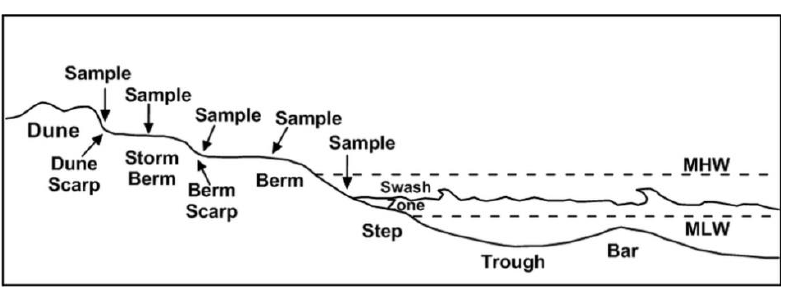
Figure A1. Typical beach profile and collection points of sand samples (image taken from USACE, 1995).